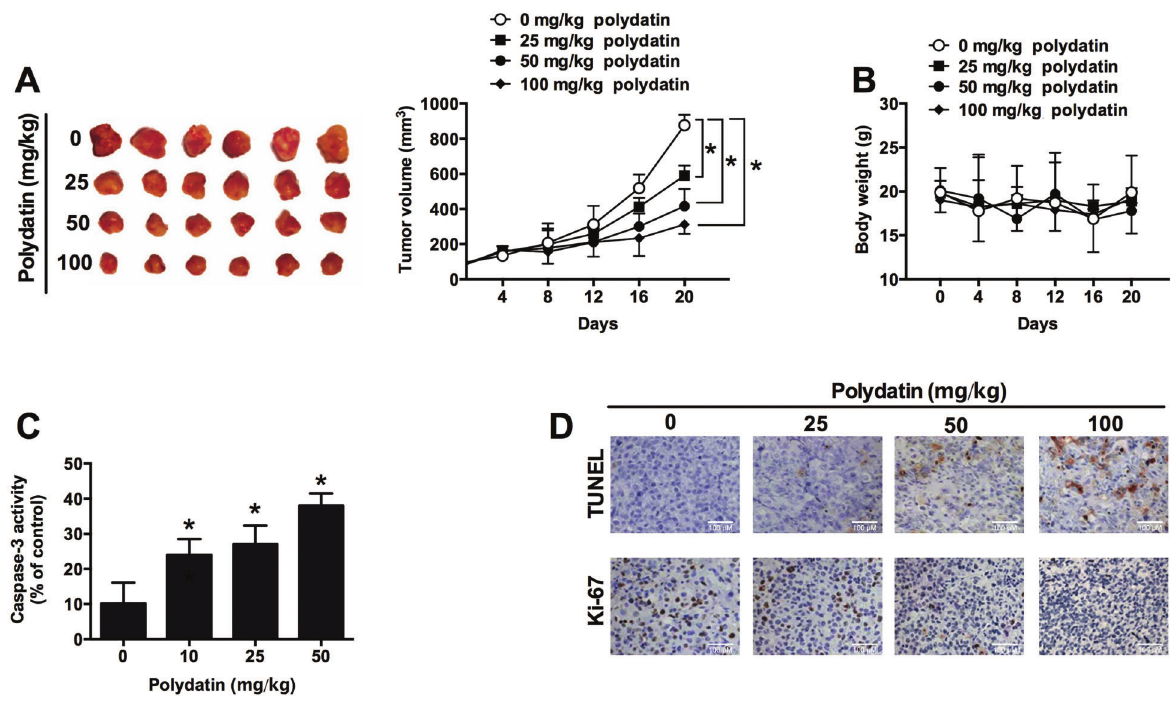
Figure 5. Effects of polydatin on tumor growth in the nude mice inoculated with HepG2 cell lines. A , tumor volume; B , body weight; C , caspase-3 activity from the resected tumor tissues; D , cell apoptosis and cell proliferation detected by TUNEL assay and Ki-67 immunostaining in the resected tumor tissues. All experiments were repeated 6 times. Data are reported as means ± SD. *P o 0.05 compared to control group (two-way ANOVA for tumor volume, one-way ANOVA for caspase-3